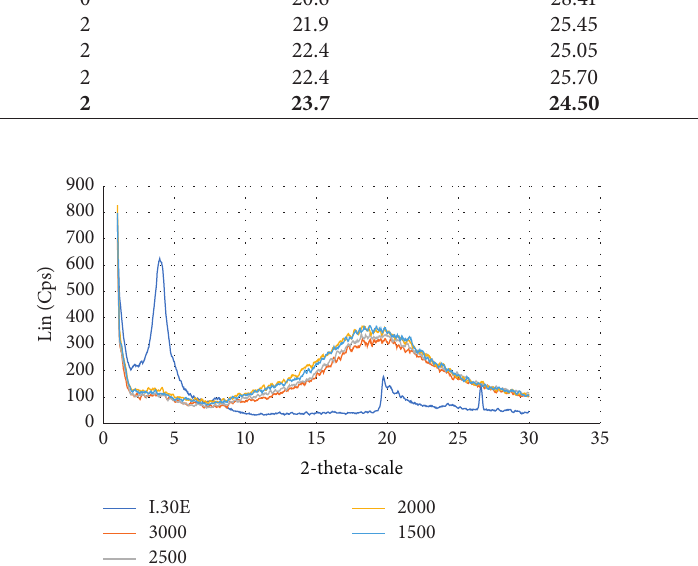
Figure 5: XRD diagram of epoxy Epikote 240/nanoclay I.30E nanocomposite at different mechanical stirring speeds: 1500rpm, 2000rpm, 2500rpm, and 3000rpm.